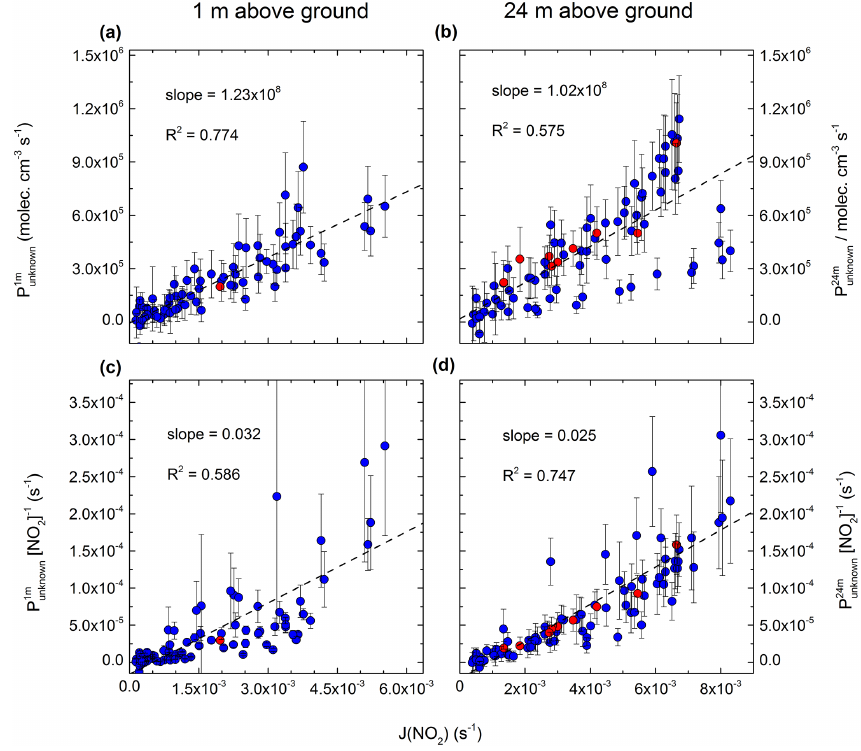
Figure 6. In the upper panels, (a) and (b) , P unknown for both measurement heights is linearly correlated with corresponding J (NO 2 ). In the lower panels, (c) and (d) , P unknown is scaled by the NO 2 concentration and still linearly correlated with J (NO 2 ). Blue dots denote budget data availability at both heights, whereas red dots are available only at the respective measurement height. Linear fits refer to total data available (blue and